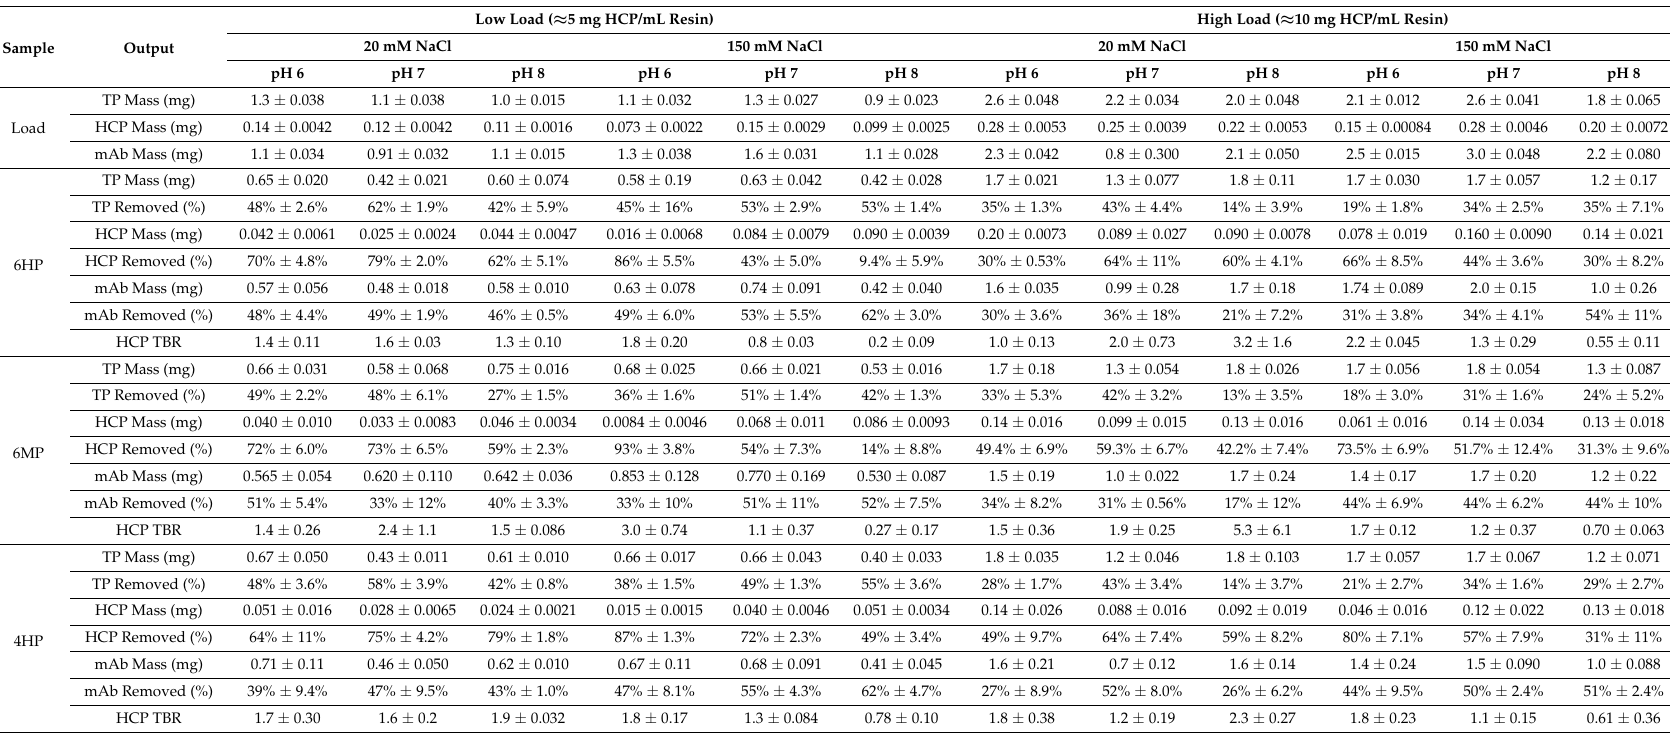
Table A1. Tabulated protein removal by resin and buffer condition. Total protein (TP), host cell protein (HCP), and monoclonal antibody (mAb) mass was calculated from the Bradford total protein determination, HCP ELISA, and EasyTiter Assay (see Materials and Methods section), multiplied by the total volume loaded for the load condition, and cumulative flow-through and wash volume collected post-static binding study. Total protein, host cell protein, and mAb removed was calculated as described in Equation (1). The resin HCP targeted binding ratio (TBR) was calculated as described in Equation